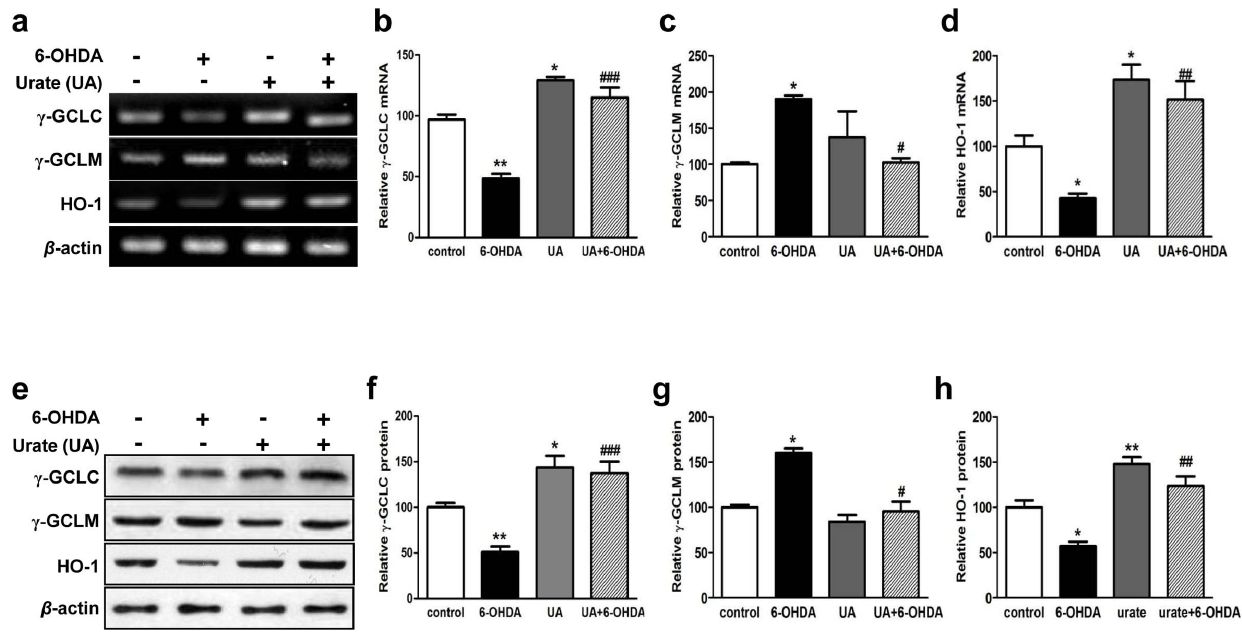
Figure 6. Effects of urate on the mRNA and protein expression of the antioxidant genes. Cells were pretreated with 200 m mol/l urate or vehicle, followed by 6-OHDA treatment for 14 h. The mRNA ( a-d ) and protein ( e-h ) levels of c -gclc , c -gclm and ho-1 were assessed by reserve transcription PCR and immunoblotting, respectively. b -actin served as loading controls. Group data were obtained by normalizing to b -actin and expressed as percentage of control values. Mean 6 SEM, n=3. * P , 0.05, ** P , 0.01 versus control; # P , 0.05, ## P , 0.01, ### P , 0.001 versus 6-